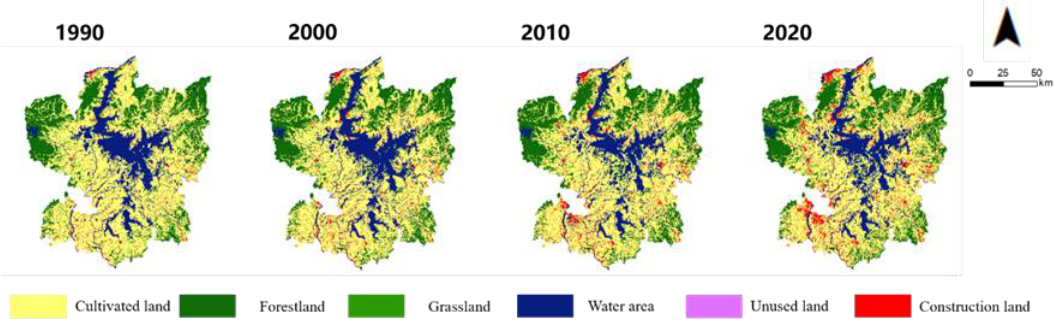
Figure 2. Land use types in Poyang Lake region from 1990 to 2020.